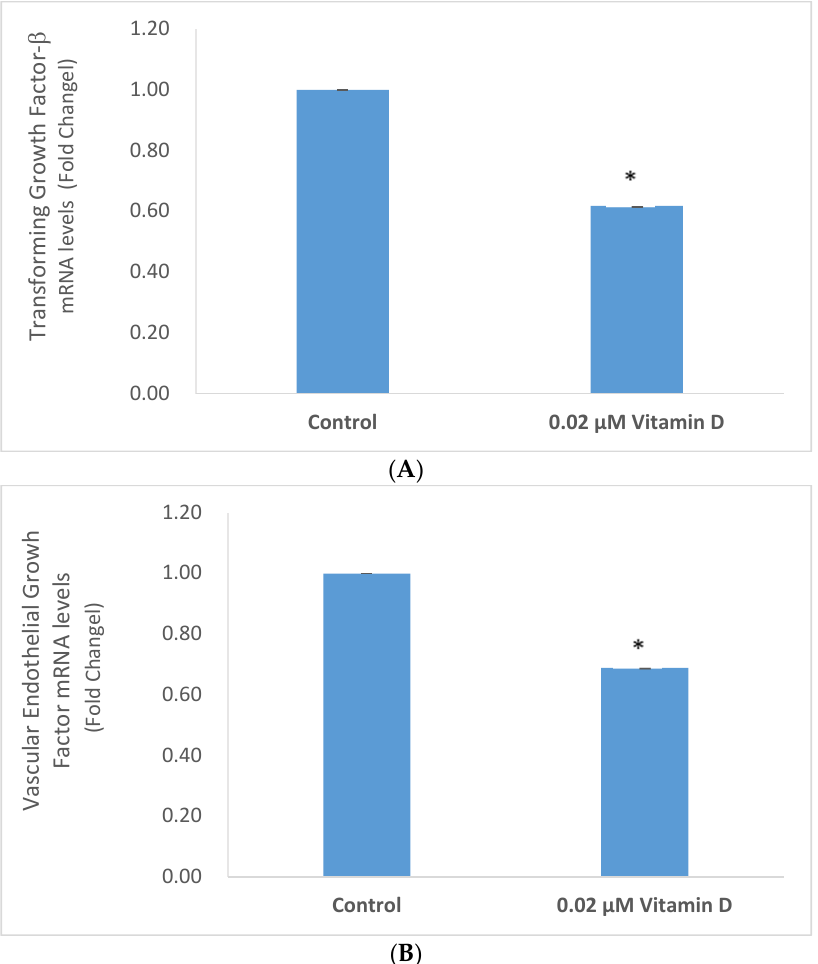
Figure 5. Effect of 1 α ,25-dihydroxyvitamin D3 (vitamin D) on transforming growth factor beta (TGF- β ) ( A ), and vascular endothelial growth factor (VEGF) ( B ) protein levels in melanoma cells; error bars: standard deviation, n = 4; * = p < 0.05, relative to control.